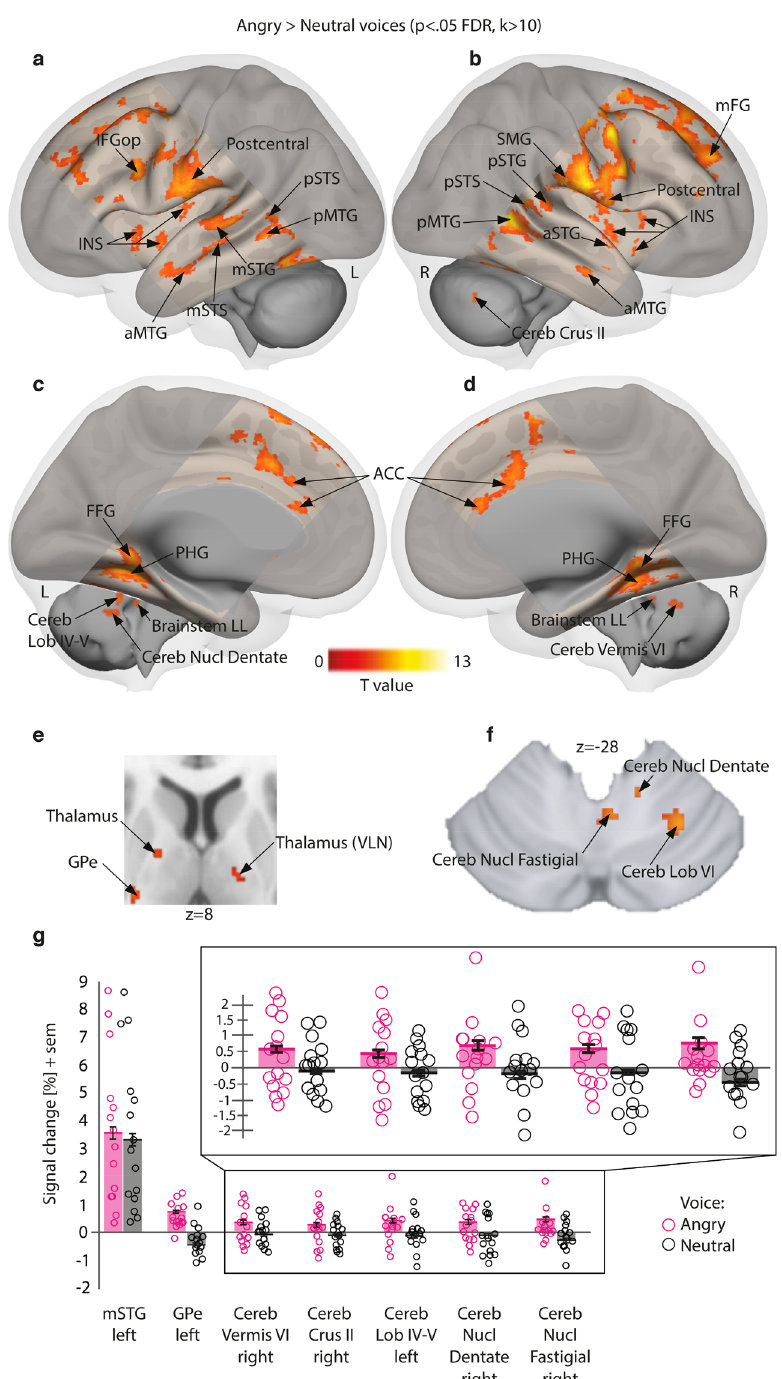
Figure 1. Enhanced brain measures for implicitly processing angry compared to neutral voices, corrected for multiple comparisons (wholebrain voxel-wise p < .05 FDR, k > 10 voxels). ( a – b ) Lateral activations rendered on a sagittal image highlighting middle and superior temporal regions. ( c – d ) Medial activations of the anterior cingulate cortex, parahippocampal cortex and cerebellum. ( e ) Subcortical activity in the thalamus and globus pallidus displayed on an axial slice. ( f ) Cerebellar activations displayed on an axial slice. G, Percentage of signal change extracted using singular value decomposition on 9 voxels around each peak in a subset of regions with individual values (circles), mean values (bars) and standard error of the mean (error bars) for angry and neutral voices. Pink circles: angry voices; Black circles: neutral voices. L: left; R: right; IFGop: inferior frontal gyrus pars opercularis; STG: superior temporal gyrus; STS: superior temporal sulcus; MTG: middle temporal gyrus; INS: insula; SMG: supramarginal gyrus; FG: frontal gyrus; FFG: fusiform gyrus; PHG: parahippocampal gyrus; ACC: anterior cingulate cortex; Cereb: cerebellum; Cereb Lob: cerebellum lobule; Cereb Nucl Dentate: dentate nucleus of the cerebellum; Cereb Nucl Fastigial: fastigial nucleus of the cerebellum; Brainstem LL: lateral lemniscus of the brainstem; Thalamus VLN: ventral lateral nucleus of the thalamus; GPe: external globus pallidus; Cereb Crus: cerebellum crus of ansiform lobule; ACC: anterior cingulate cortex. ‘a’ prefix: anterior part; ‘m’ prefix: mid part; ‘p’ prefix: posterior